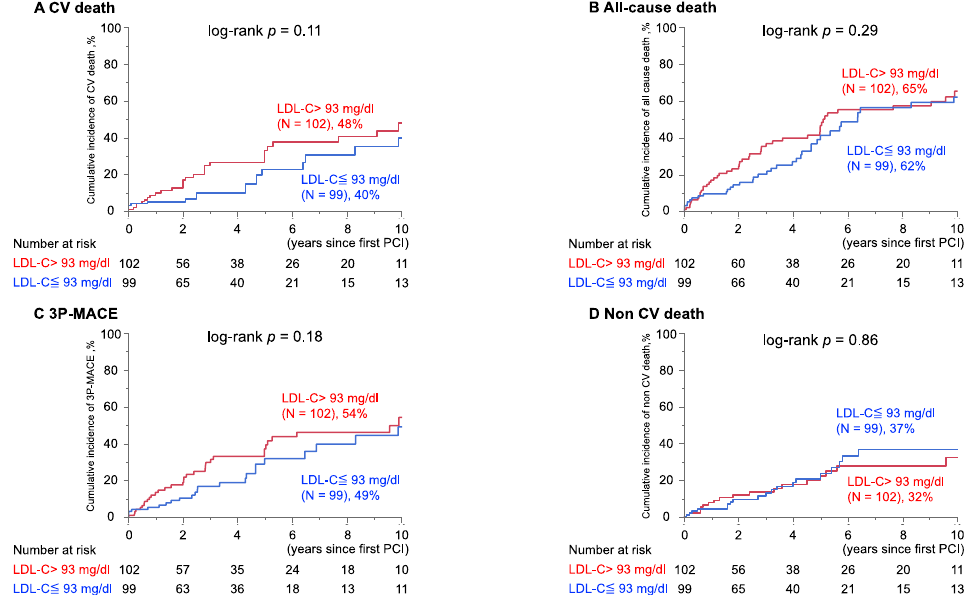
Figure 2. Cumulative cardiovascular event rates in groups divided by median LDL-C at procedure. Similar cumulative incidences of ( A ) CV death, ( B ) All-cause death, ( C ) 3P-MACE and ( D ) Non CV death in patients with and without LDL-C higher than median (>93 mg/dL). Percent indicates the cumulative incidence of events at 10 years of follow-up in each group.